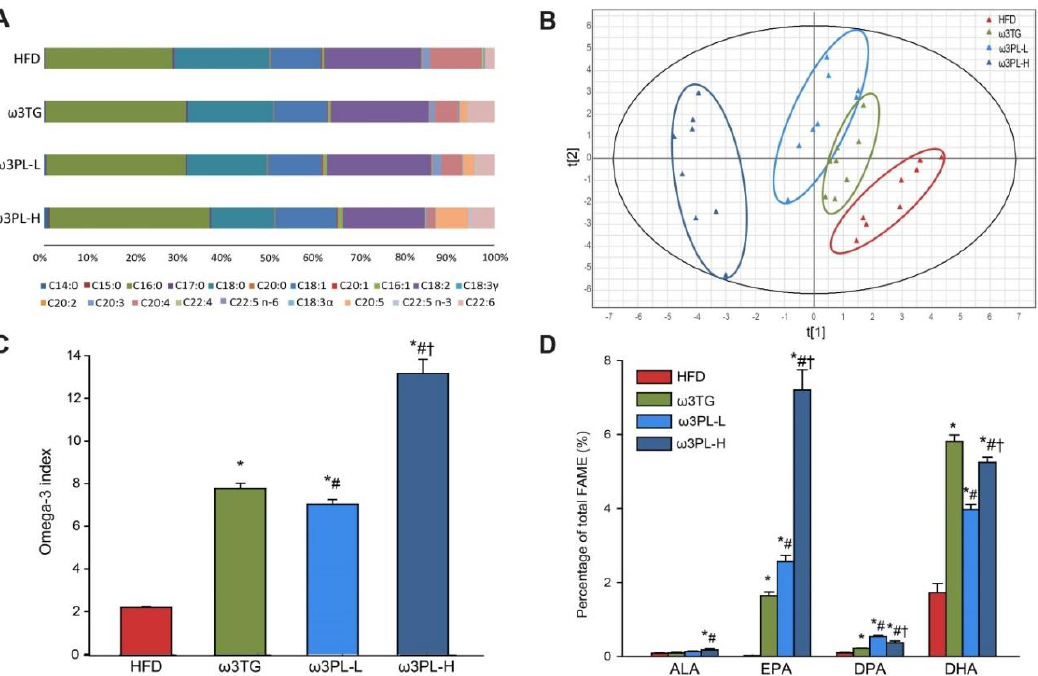
Figure 3. The long-term Omega-3 dietary supplementation affected FA composition of cell membranes. Distribution of FA in the phospholipid fraction of RBCs ( A ) and score plot as assessed by partial-least-squares discriminant analysis (PLS-DA) based on the FA composition in total phospholipids of RBC ( B ) from mice after 8 weeks of dietary intervention. Incorporation of Omega-3 in the RBC membranes expressed as the Omega-3 index ( C ) or relative content of individual Omega-3, ALA, EPA, DPA and DHA ( D ). Data are mean percentage of total FA in phospholipid fraction ( A ) or mean percentage ± SEM ( C , D ) ( n = 8). *, significantly different vs. HFD; #, significantly different vs. ω3TG; †, significantly different vs. ω3PL-L ( p < 0.05, one-way ANOVA). For detailed FA composition of RBCs phospholipids including Chow-fed mice, see Table S3.